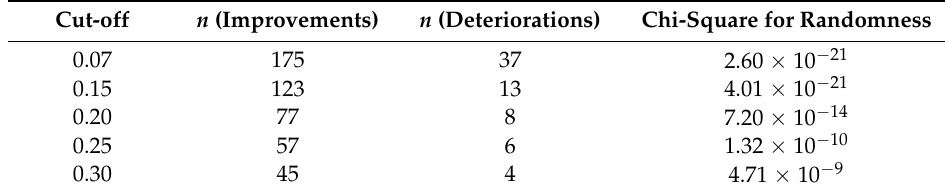
Table 4. Sensitivity analysis for changes of the cut-off values for clinical relevance and corresponding p values.